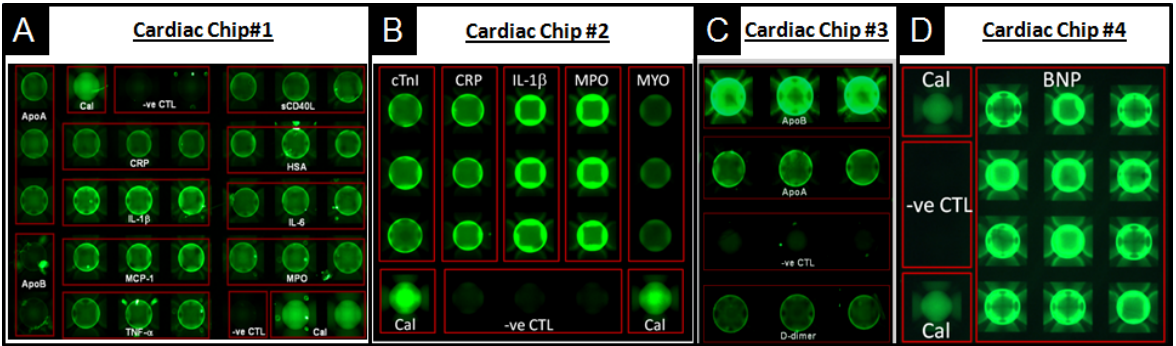
Figure 9. The p-BNC diagnostic applications for cardiovascular disease include ( A ) Risk for primary cardiac event chip: Apolipoprotein A1 (ApoA1), Apolipoprotein B (ApoB), C-reactive protein (CRP), Interleukin-1beta (IL-1b), Monocyte chemoattractant protein-1 (MCP-1), Tumor necrosis factor-alpha (TNF-a), Soluble CD40 ligand (sCD40L), Human serum albumin (hsa), Interleukin-6 (IL-6) and Myeloperoxidase (MPO); ( B ) Expanded AMI diagnosis chip: Cardiac troponin I (cTnI), Myoglobin (CRP), IL-1 β , MPO and MYO; ( C ) Risk for secondary cardiac events chip: ApoA1, ApoB and D-dimer; and ( D ) Congestive heart failure chip: Brain natriuretic peptide